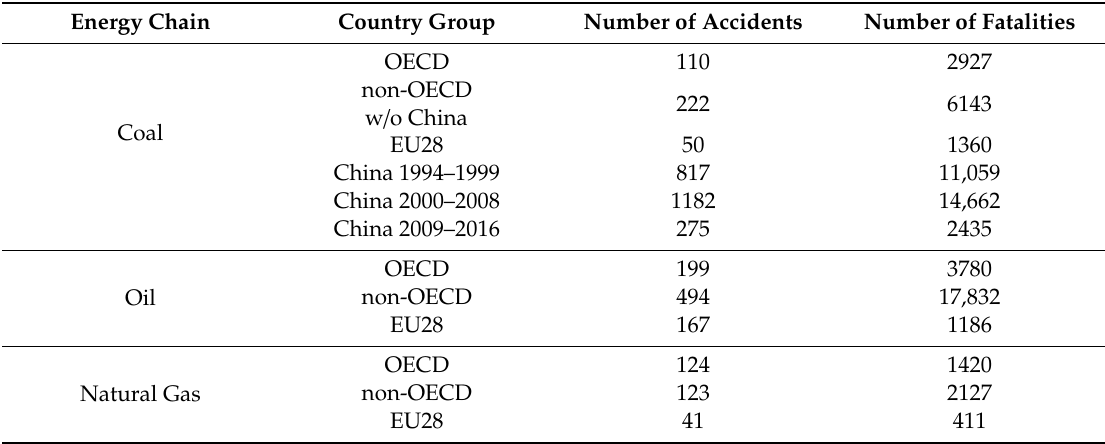
Table 1. Total numbers of severe ( ≥ 5 fatalities) accidents and their respective fatalities for selected energy chain and country group combinations in the years